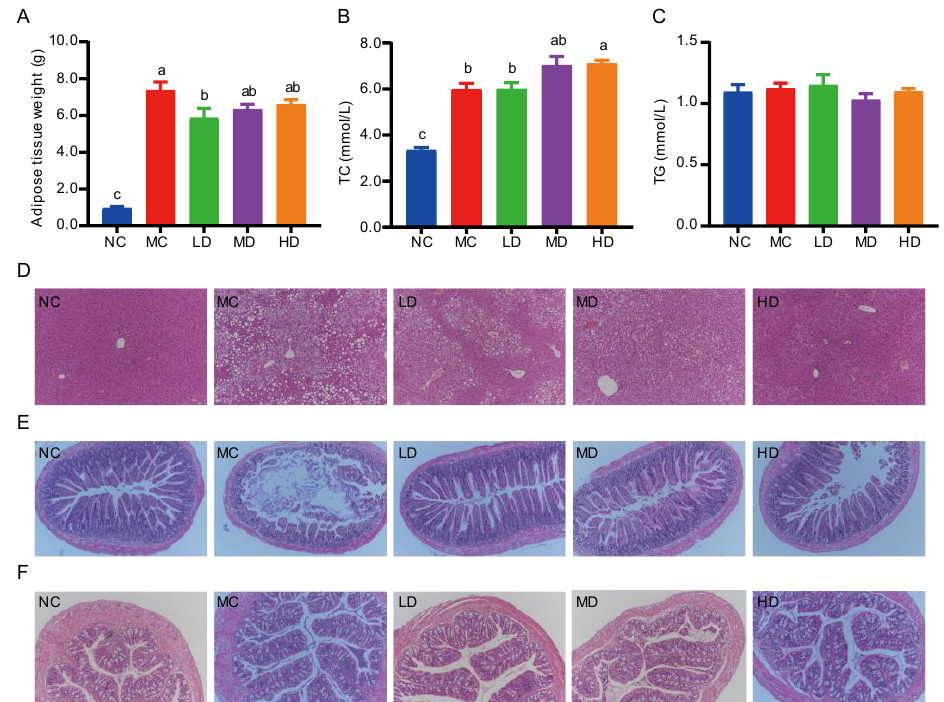
Figure 1. Effect of PHB on the bodyweight, food intake, and glucose metabolism in HFD mice. ( A ) Bodyweight. ( B ) Food intake. ( C ) Fasting blood glucose. ( D – F ) OGTT curve and AUC at week 0 ( D ), week 6 ( E ), and week 12 ( F ), respectively. Results are presented as mean ± SEM ( n = 8). Different letters are significantly different ( p < 0.05) based on Tukey multiple range test. PHB, partly milled highland barley; NC, normal control group; MC, model control group fed HFD; LD, low-dose group fed HFD containing 10% PHB; MD, middle-dose group fed HFD containing 20% PHB; and HD, high-dose group fed HFD containing 30% PHB.